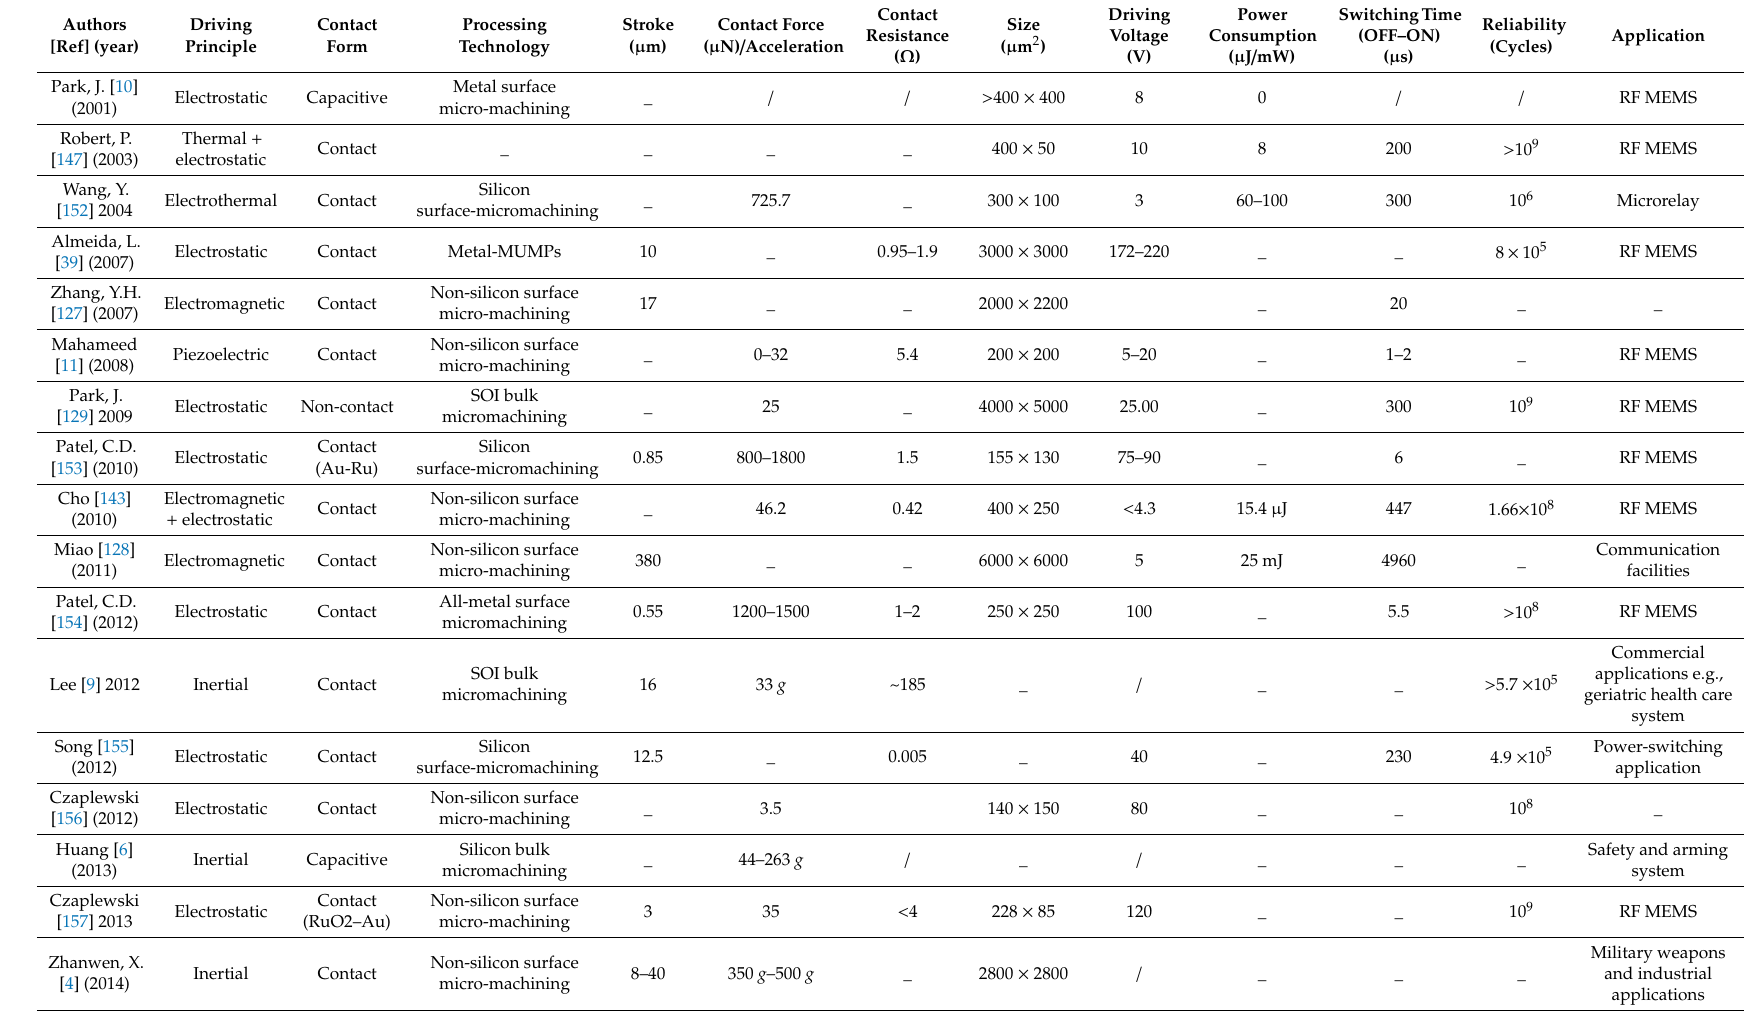
Table 3. Trait comparison of MEMS switches in di ff erent